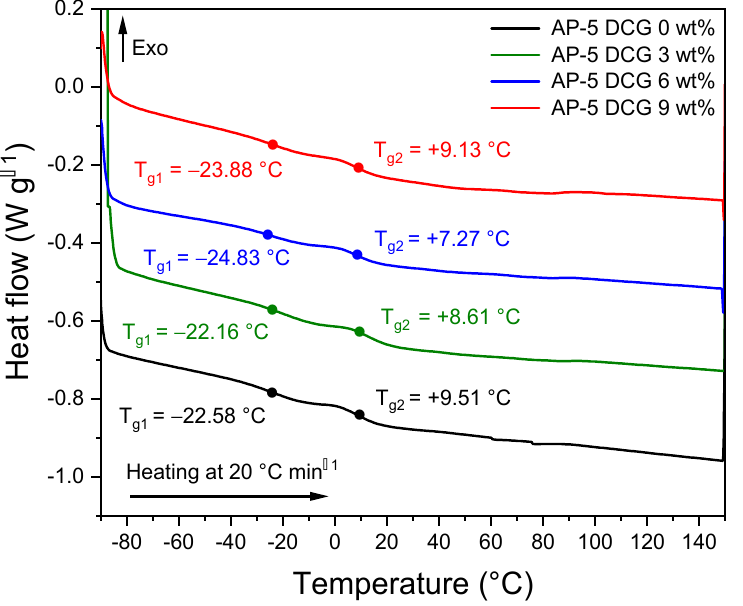
Figure 18. DSC thermograms of base AP-5 asphalt and its specimens loaded with various fractions of DCG (e.g., 3, 6, and 9 wt%).